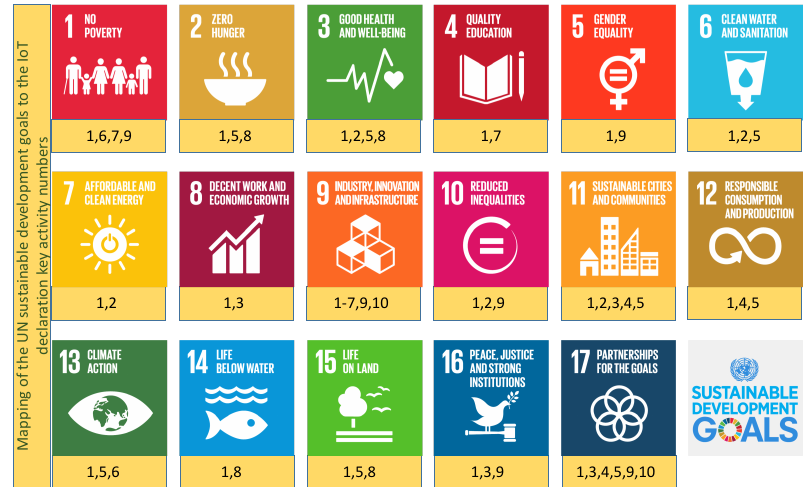
Figure 2. The United Nations General Assembly 2030 development agenda Sustainable Development Goals mapped to the ITU Internet of Things declaration activity numbers